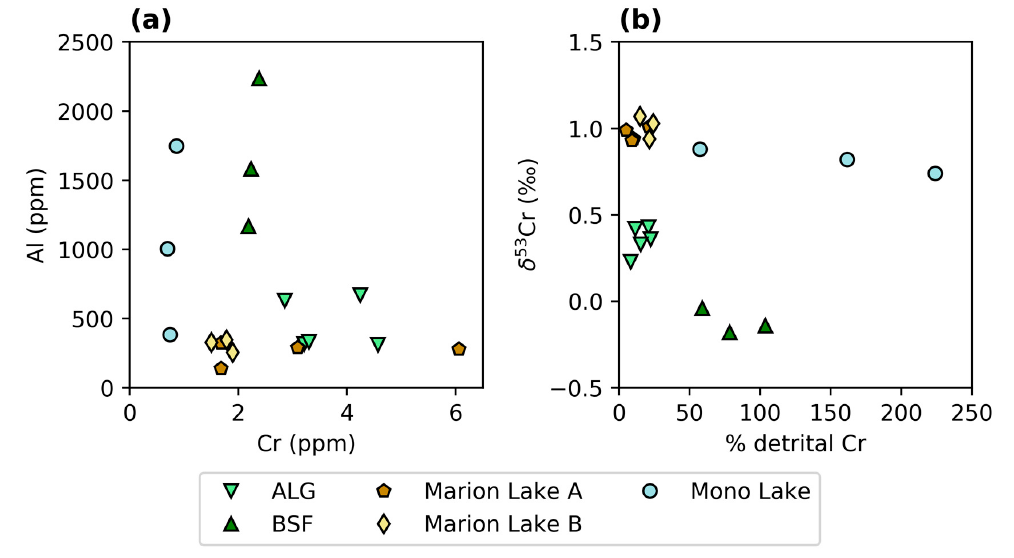
Figure 3. Cr concentrations ( a ) and isotope compositions ( b ) of microbialites and the estimated Marion Lake water samples (dashed grey line). Numbers on y-axis indicate the sample position (see Figure 1 and Table 1).